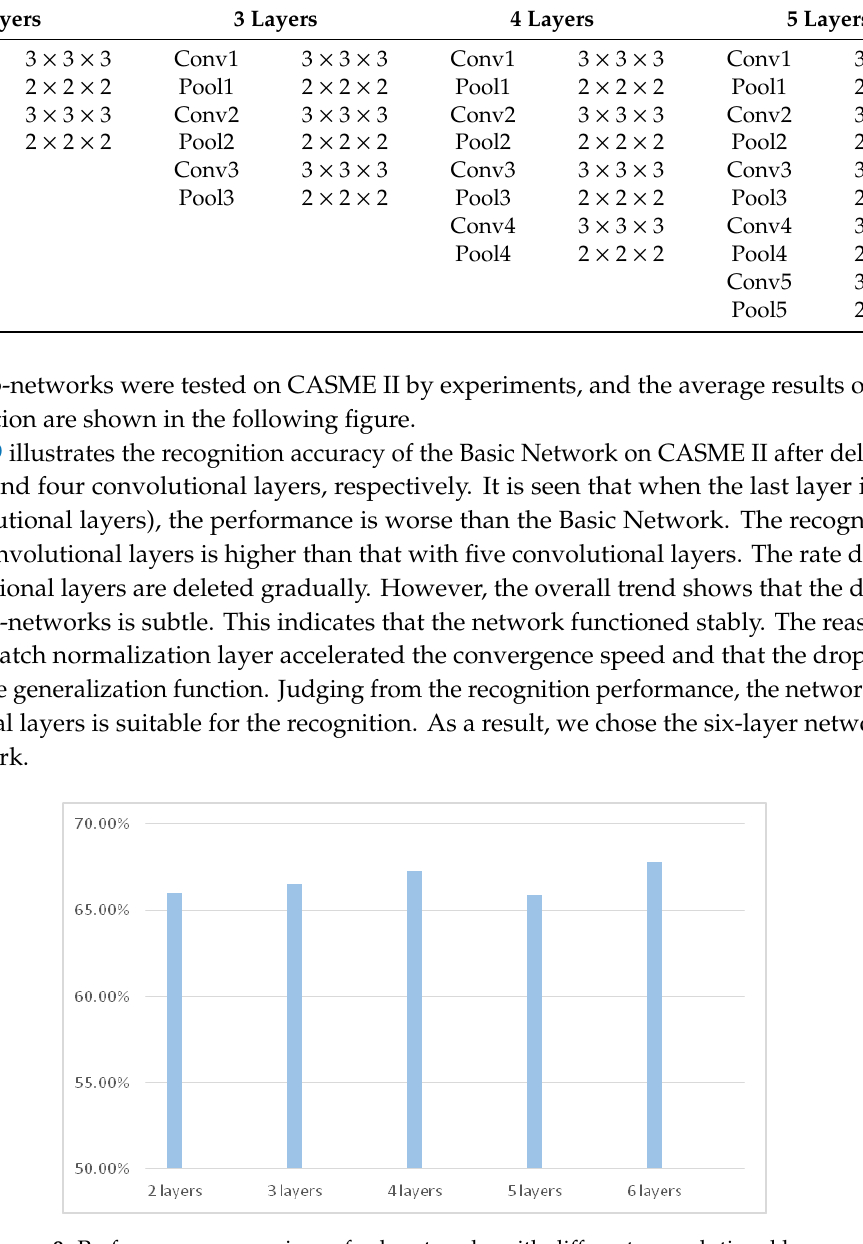
Figure 9. Performance comparison of sub-networks with different convolutional layers.